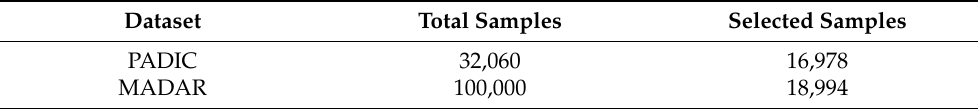
Table 4. Our selected samples from MADAR and PADIC datasets in which the input and output are the same